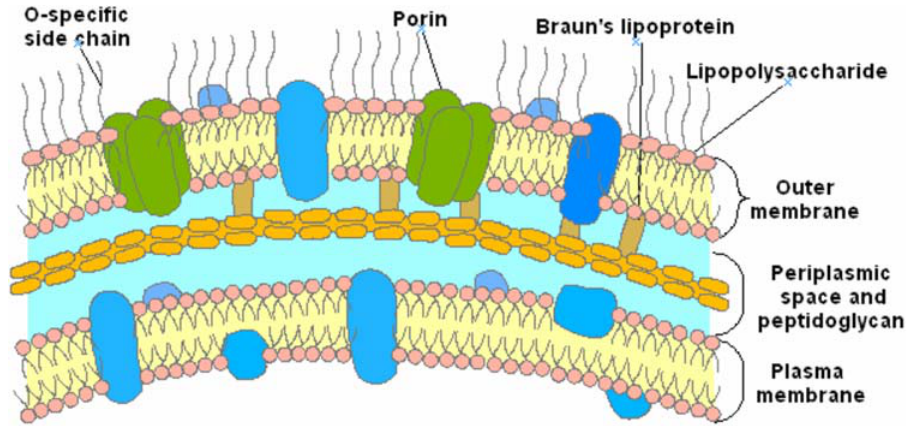
Figure 1. Gram negative bacteria envelope.